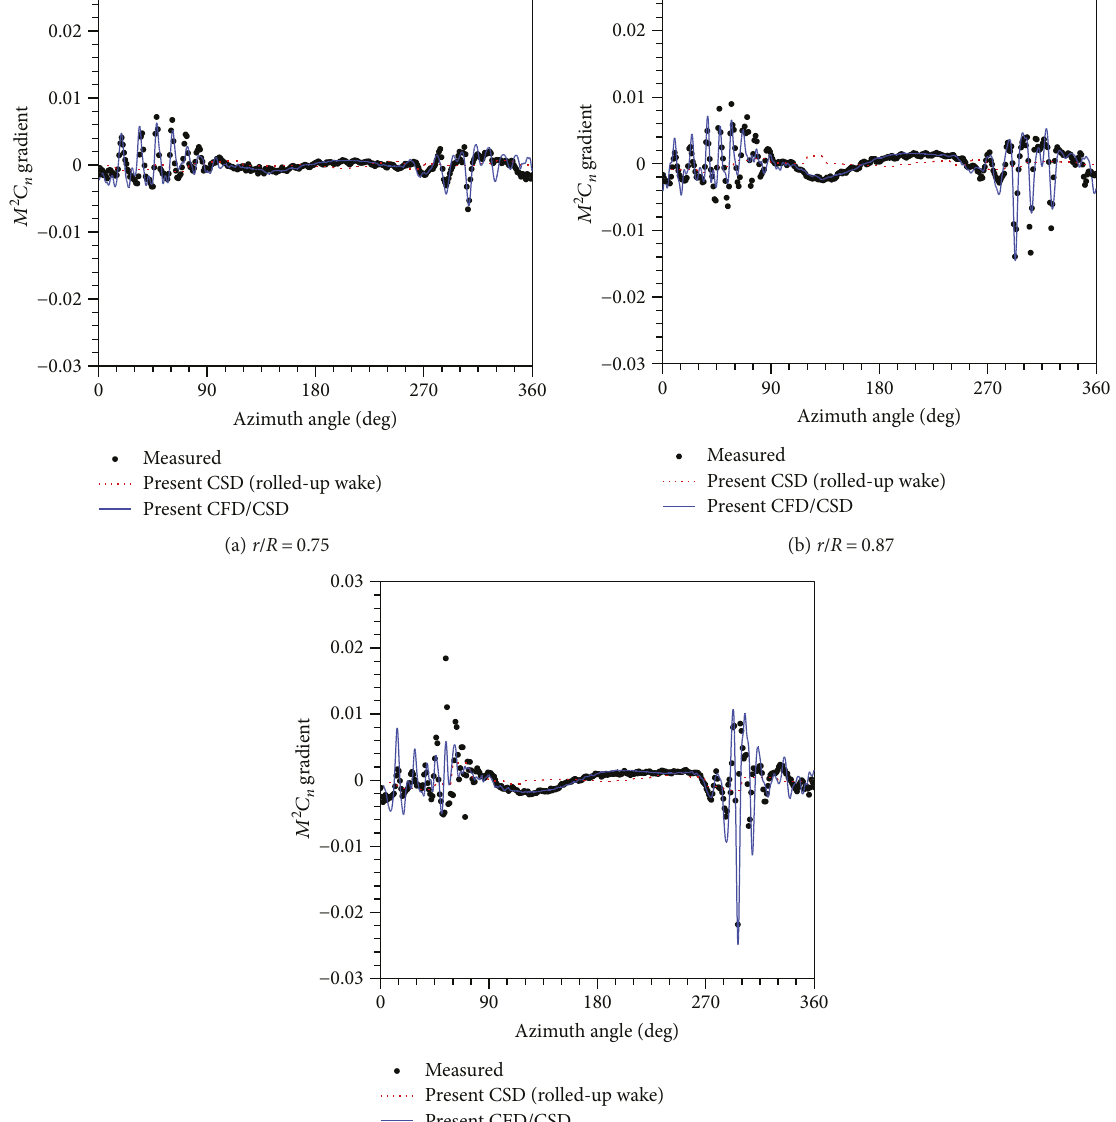
Figure 15: Correlation of the gradient of section normal forces d M 2 C